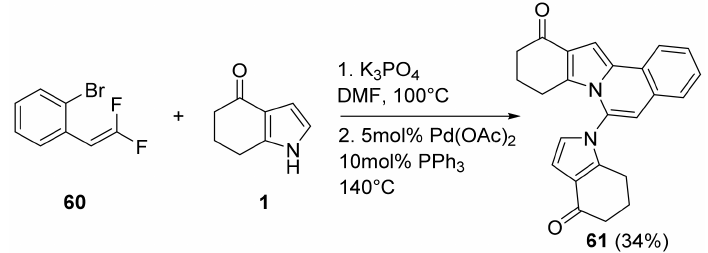
Scheme 10. Synthesis of N -fused isoquinoline